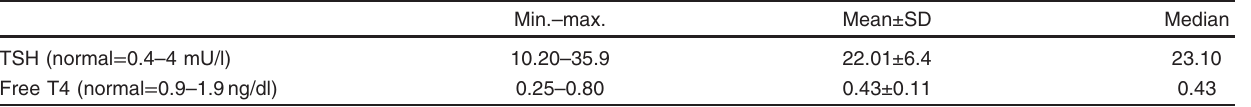
Table 2 The reported serum levels of thyroid-stimulating hormone and free T4 among the selected patients ( n = 30) at the start of the study